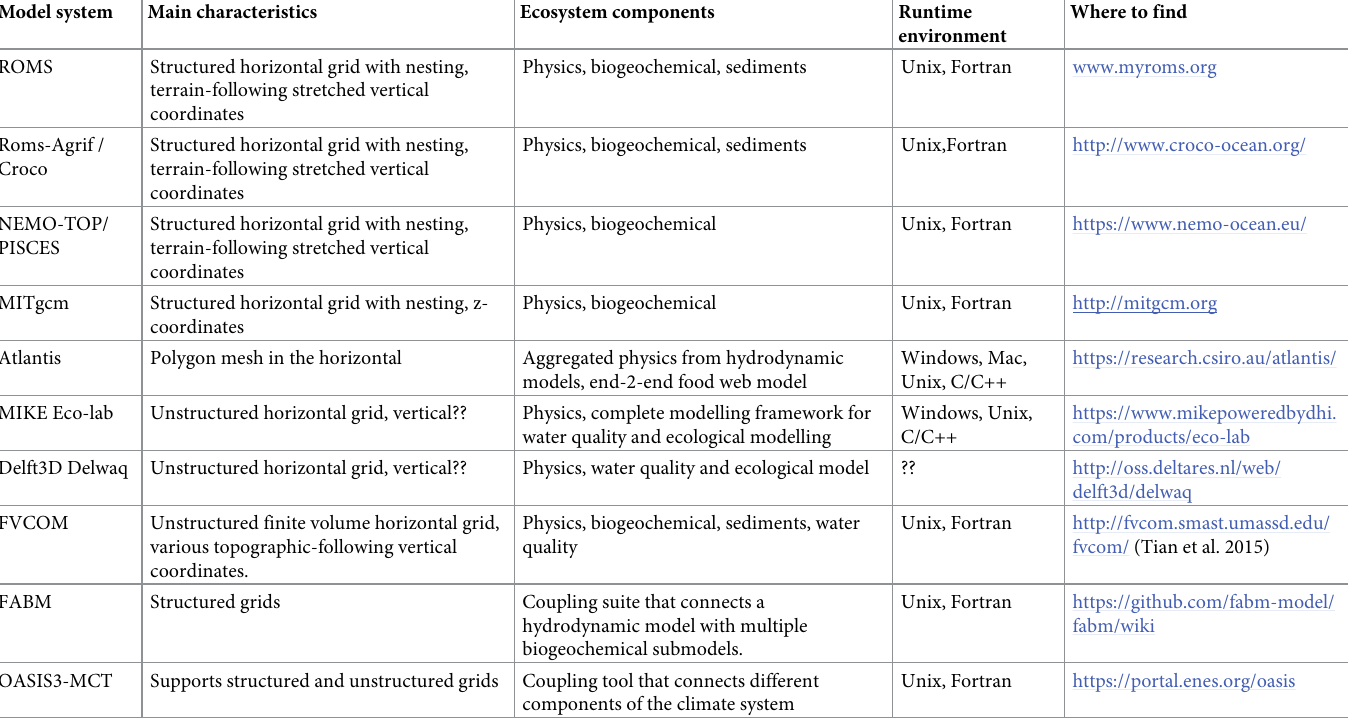
Table 1. Non-exhaustive list of ocean model systems and their main characteristics and